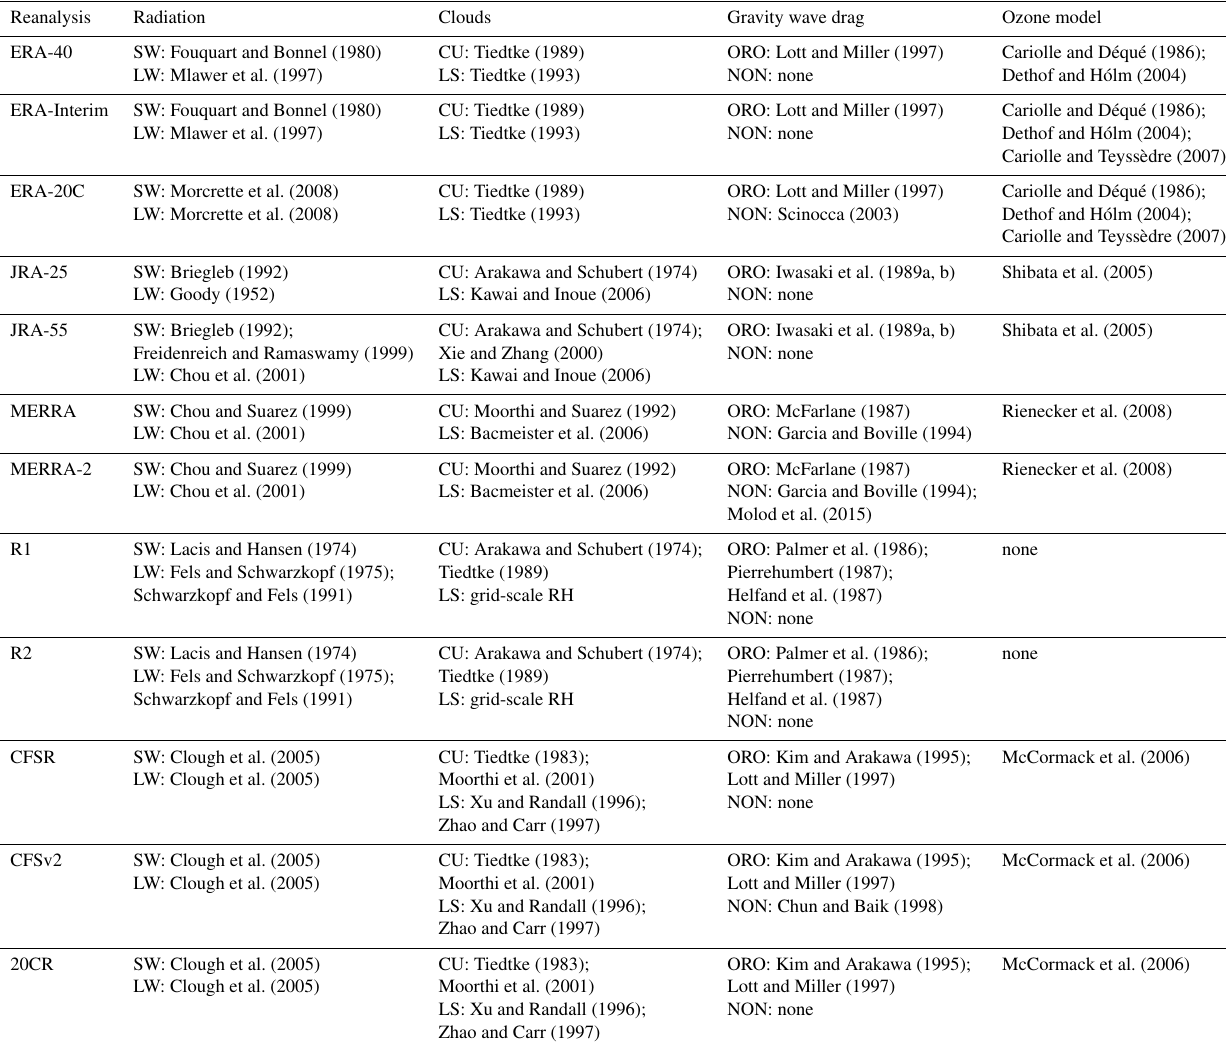
Table 3. Major physical parametrizations in the reanalysis forecast models. Radiation parametrizations are divided into shortwave (SW) and longwave (LW), cloud parametrizations are divided into convective (CU) and non-convective (LS), and gravity wave drag parametrizations are divided into orographic (ORO) and non-orographic (NON)